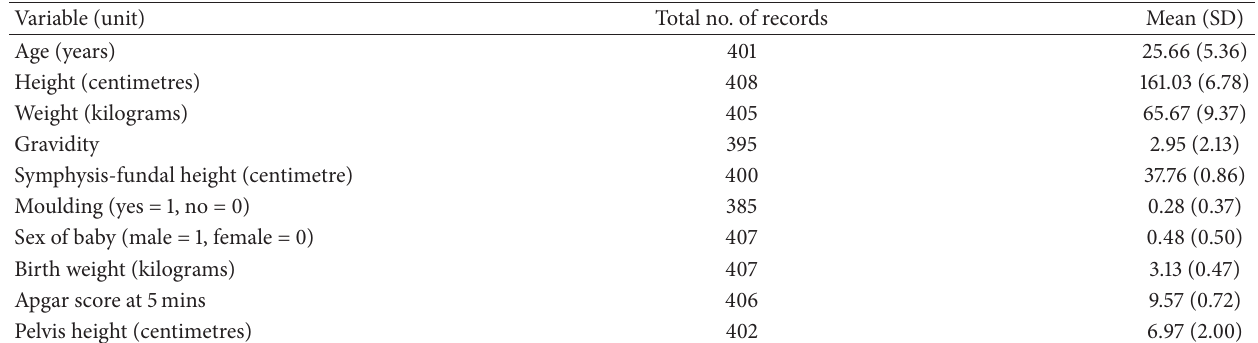
Table 1: Descriptive statistics for the study